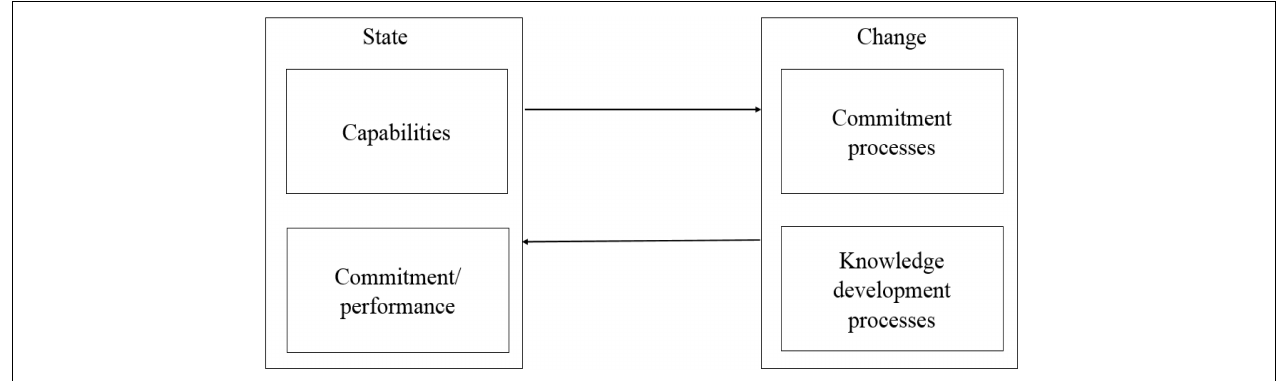
FIGURE 1 | The process of internationalisation (IP) model (Johanson and Vahlne, 2017).